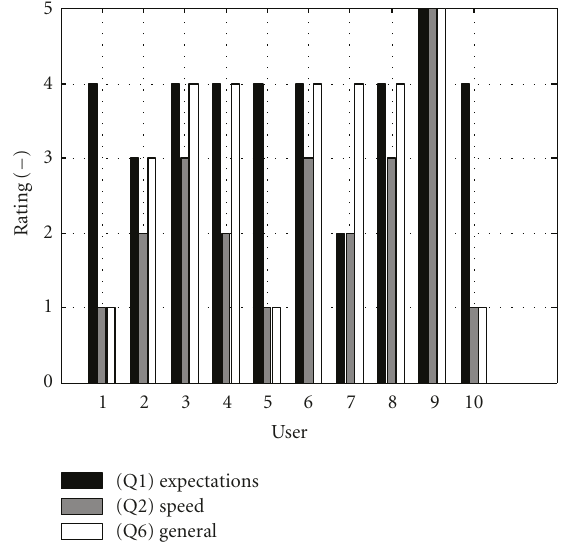
Figure 6: Ratings of the questionnaire (Q1, Q2, and Q6) for all users at location 4 (very low signal